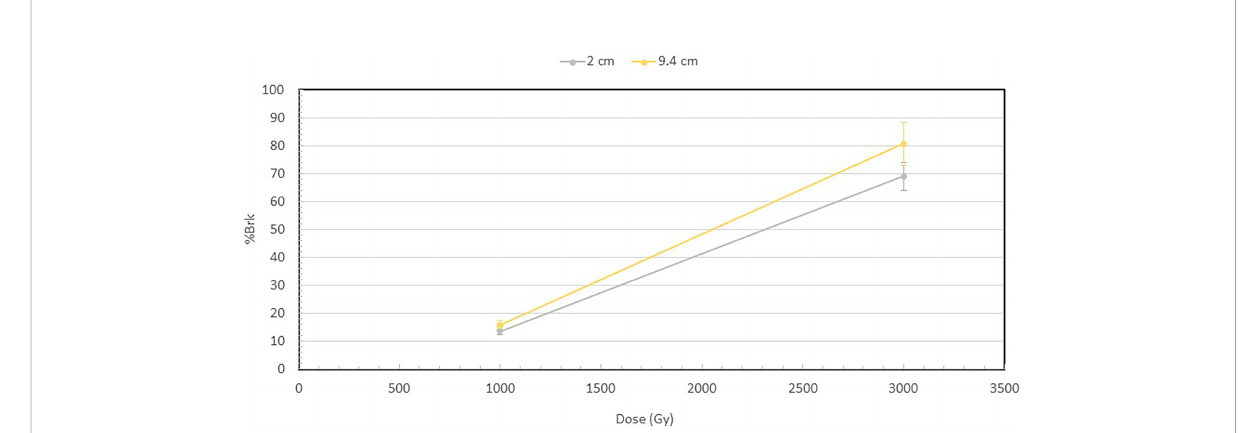
FIGURE 3 Percentage of broken DNA molecules at the depths of 2 and 9.4 cm for the 1000 and 3000 Gy irradiated DNA. At 1000 Gy, 13.9% of the DNA were broken at 2 cm, while 15.7% at 9.4 cm. At 3000 Gy, 69% of DNA were broken at 2 cm and 80.6% at 9.4 cm. The fraction of broken DNA is the ratio of the number of broken DNA to that of the total number of DNA, which is the sum of both broken DNA and intact DNA. The number of broken DNA is calculated by summing the lengths of the broken DNA fragments and then dividing by the length of an intact DNA.